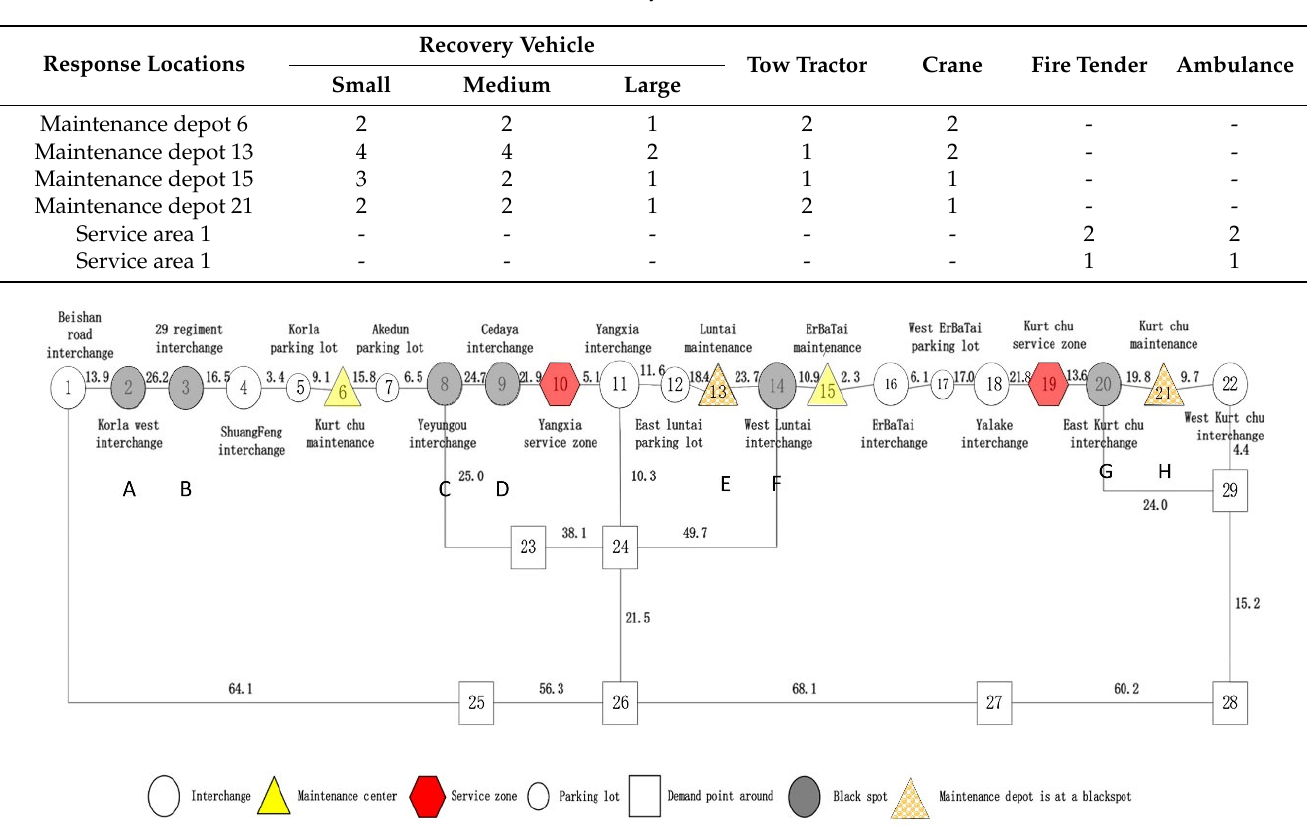
Table 4. Allocation result of every rescue vehicle ( Q = 0.7).